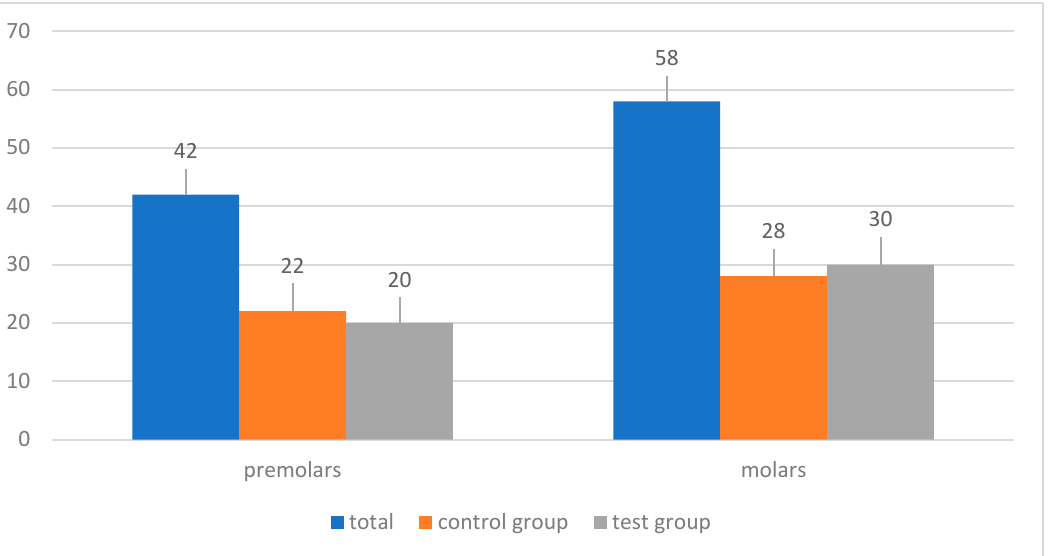
Figure 3. Distribution of the study teeth at baseline.